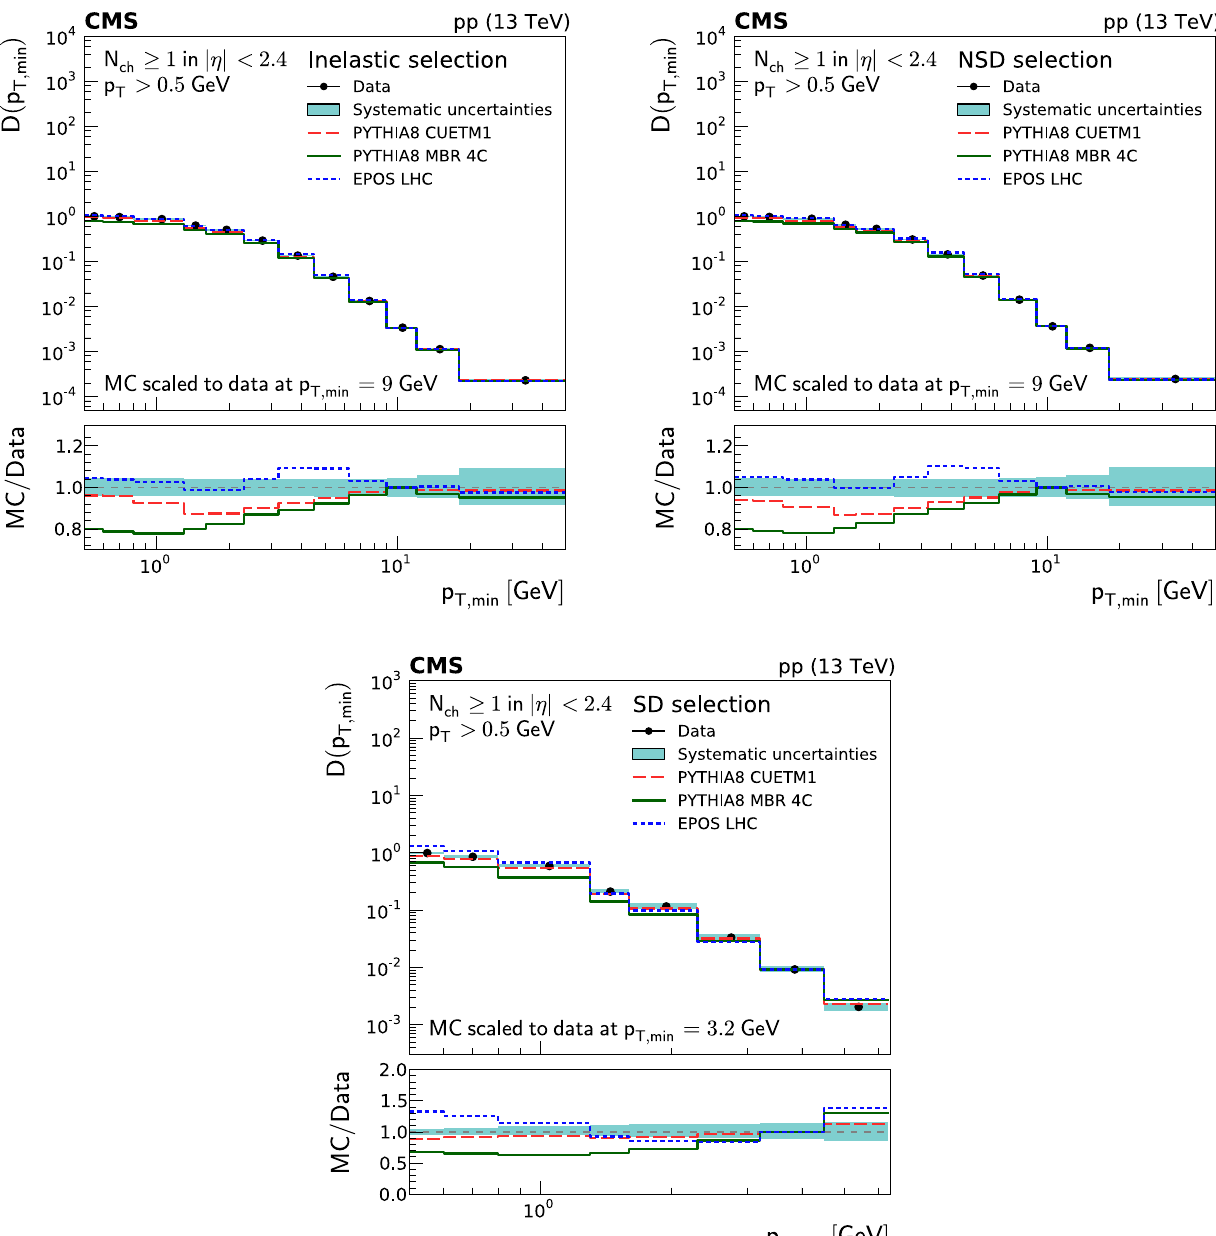
Fig. 6 Integrated leading charged particle p T distributions as a func- tion of p T,min for inelastic (top left), NSD-enhanced (top right), and SD- enhanced (bottom) event samples. The measurements are compared to the predictions of the pythia 8 cuetm1 (long dashes), pythia 8 mbr4c (continuous line), and epos LHC (short dashes) event generators. The